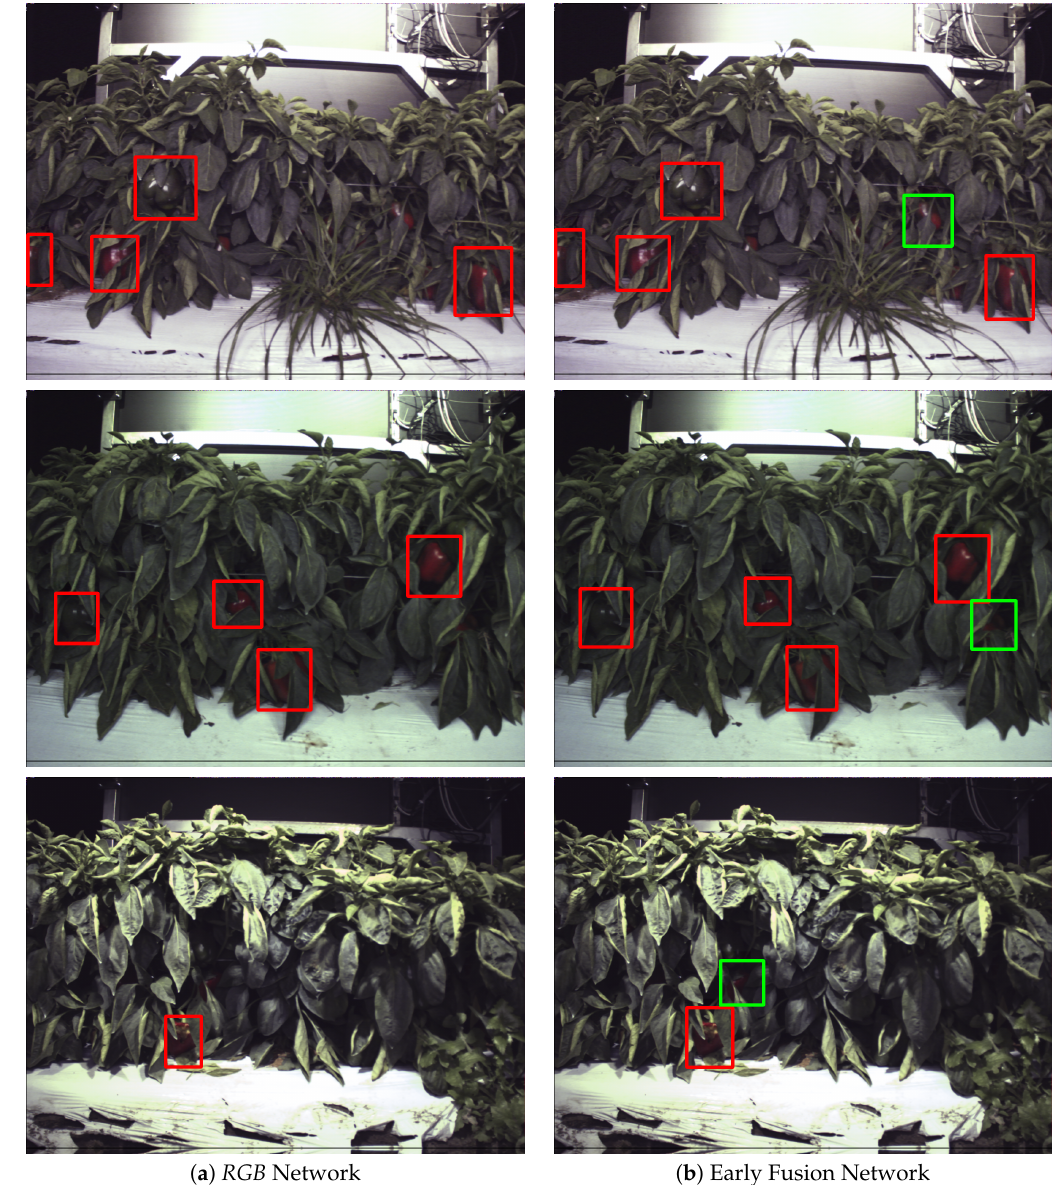
Figure 10. DeepFruits evaluation: Early Fusion (right) and RGB (left) models evaluated on the DeepFruits Capsicum data. It can be seen that the early fusion approach more frequently detects objects the RGB network misses (highlighted in